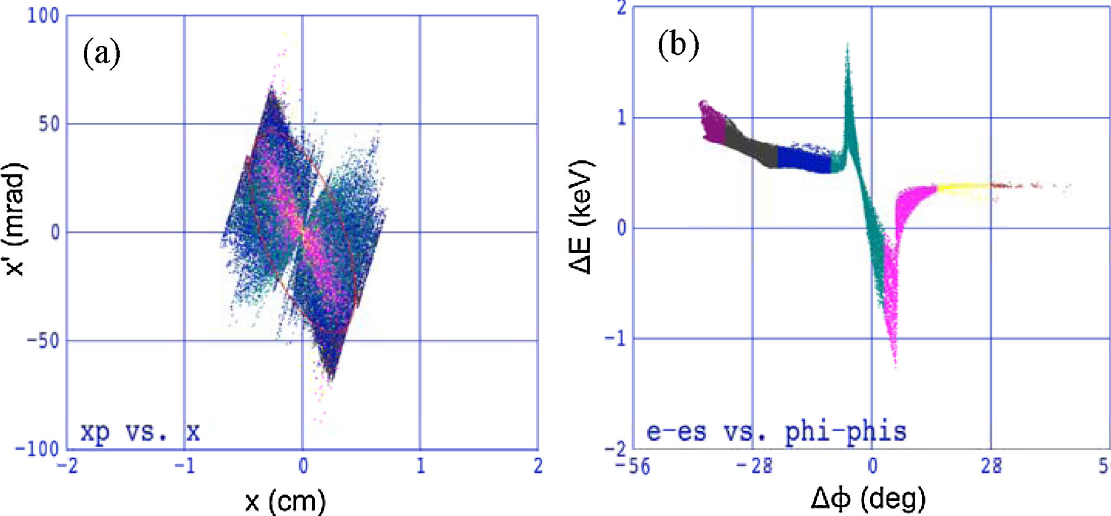
FIG. 21. (a) Transverse and (b) longitudinal phase space from the PARMELA simulation of Fig. 20 at the exit of the gun ( z ¼ 5 : 0 cm ). The normalized transverse emittance is 16 mm mrad and the longitudinal emittance is 7 keV psec. Particles are grouped by color into six longitudinal slices, with each slice containing particles of a given range in rf phase at z ¼ 5 : 0 cm